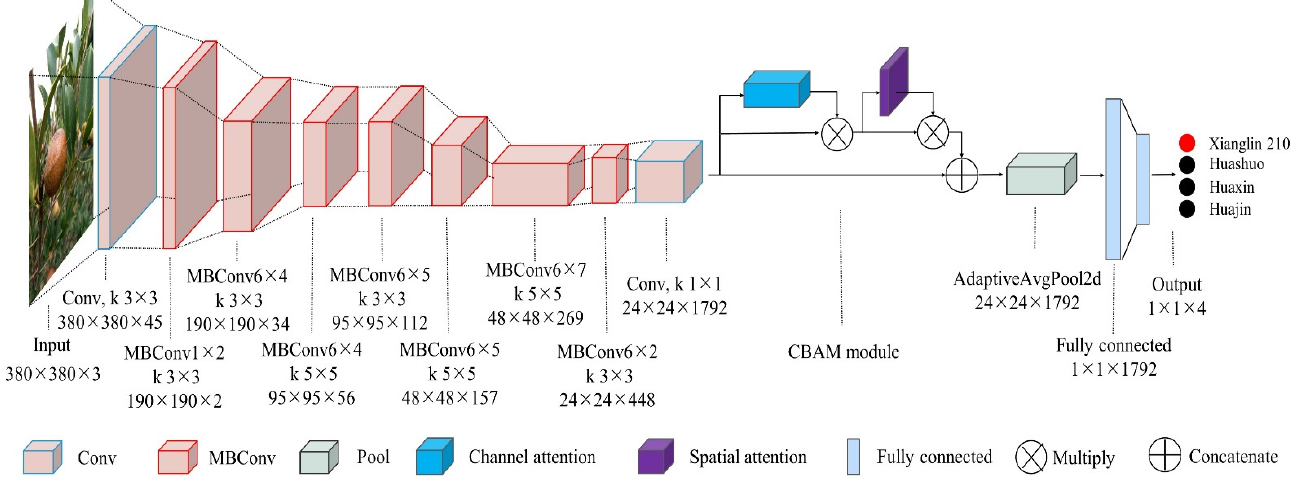
Figure 2. Framework of the proposed EfficientNet-B4-CBAM for oil tea cultivar identification. Input denotes input image of oil tea; N × N × C represents the size of feature map, where N × N is the 2D map size and C is the number of channels; Conv denotes pointwise convolution; k n × n represents the convolution kernel of n × n; MBConv represents mobile inverted bottleneck convolution; MBConv1 × n indicates n MBConv1 modules; MBConv6 × n indicates n MBConv6 modules; CBAM denotes convolutional block attention module; AdaptiveAvgPool2d represents adaptive average pooling; Fully connected represents fully connected layer; Output represents output layer.